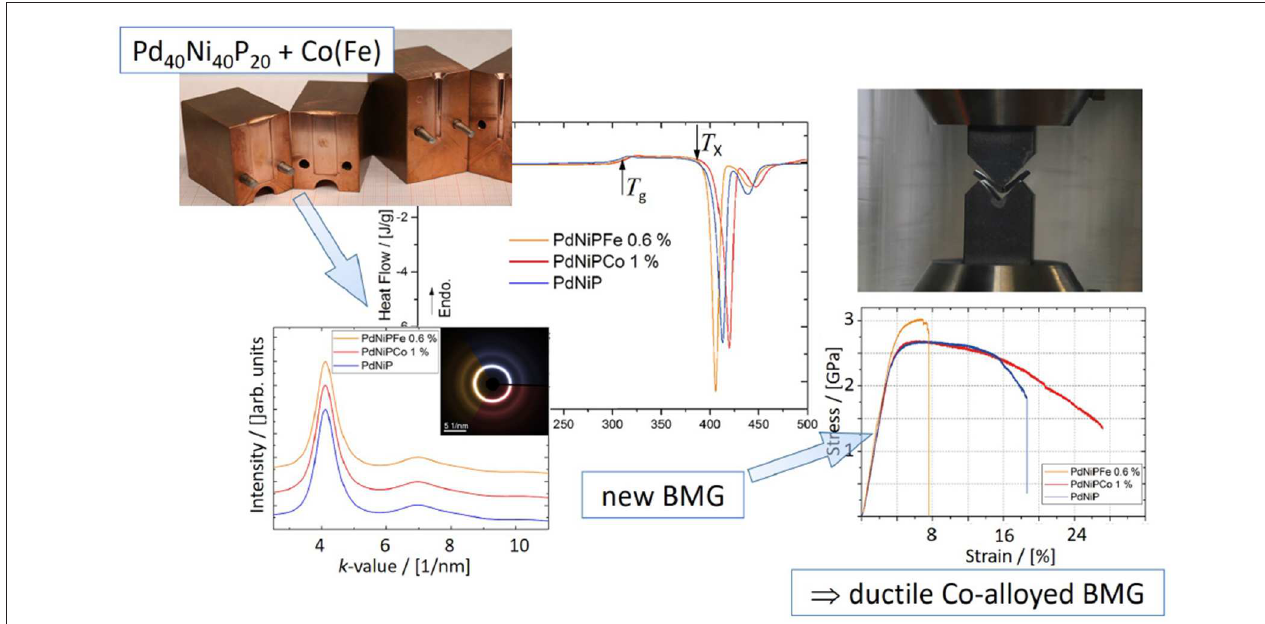
FIGURE 8 | Workflow showing the whole process of micro-alloying from casting panel, characterization to the mechanical testing, adopted from Nollmann (2018). First, the glasses is produced by casting into a copper mold (top-left) . Furthermore, the sample are tested for their amorphousness through X-ray diffraction (bottom-left) and differential scanning calorimetry (center) measurements. Finally, the sample is subjected to a three-point bending test (right) .